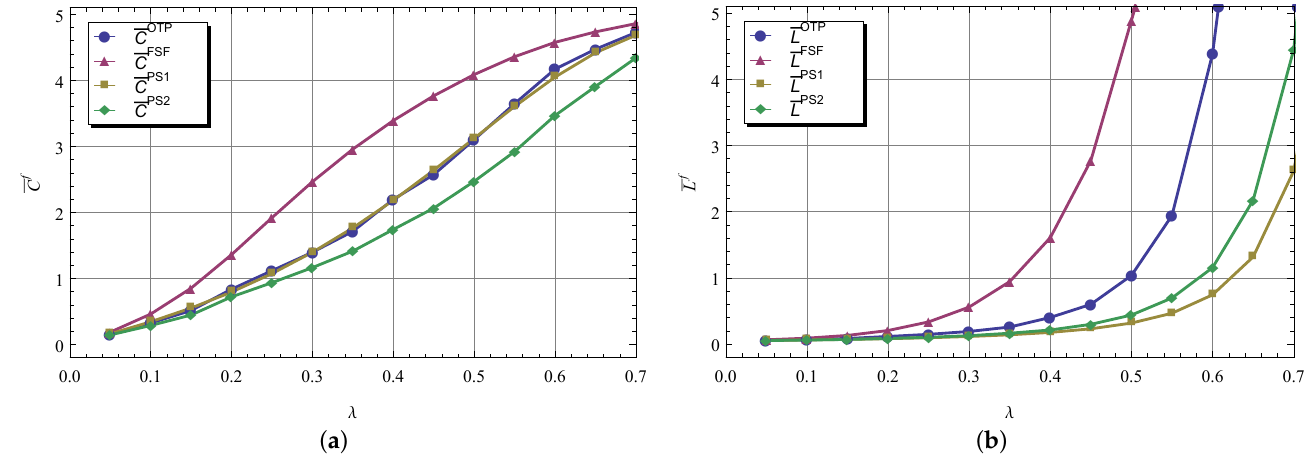
Figure 4. ¯ C f ( a ) and ¯ L f ( b ) versus λ